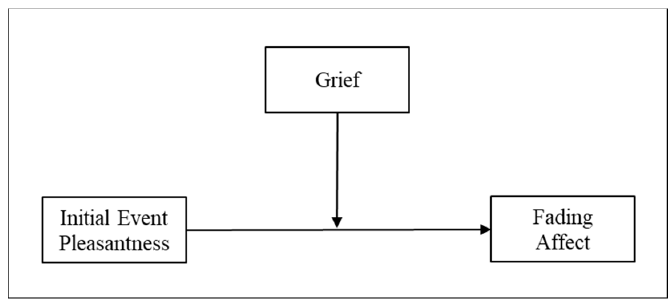
Figure 1. Two-way interaction between grief and initial event affect in predicting fading affect.